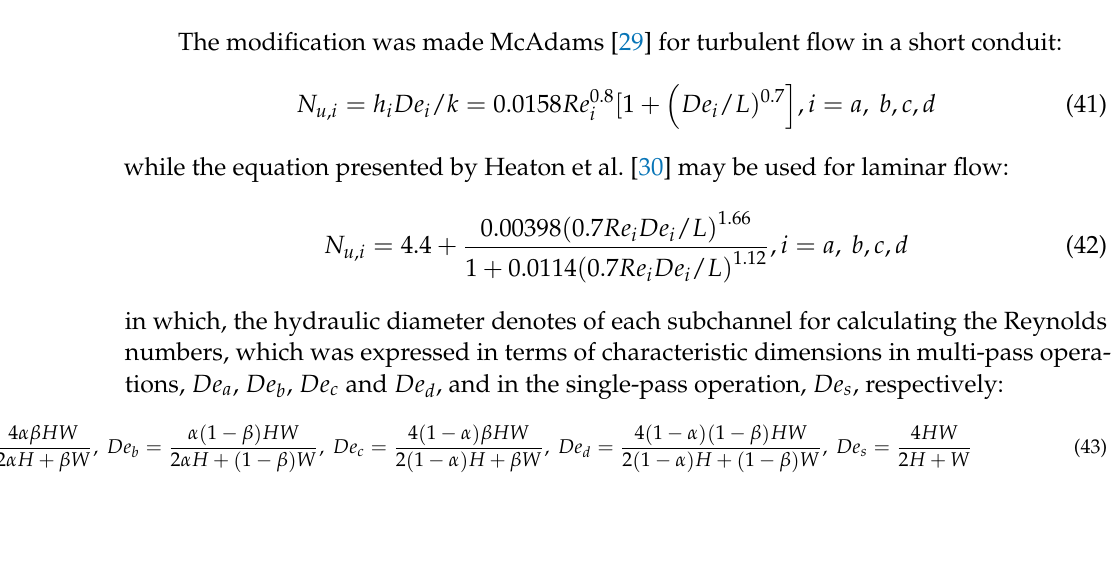
Figure 3. The heat-transfer coefficients for all parts of the solar air collector: ( a ) Front view; ( b ) Side view.